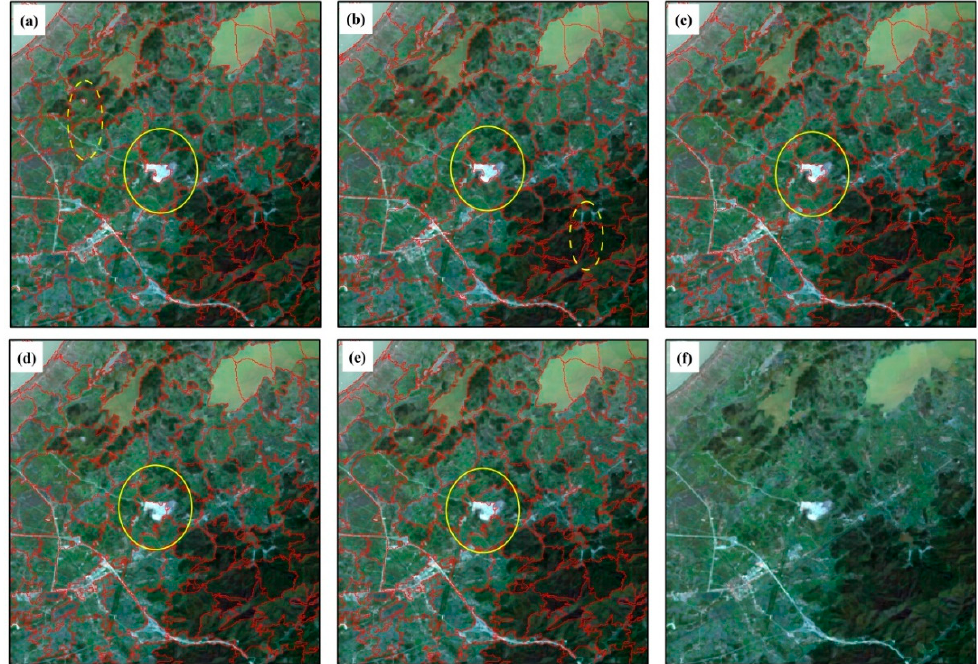
Figure 9. Image segmentation results for different spectral standard deviations in a typical area. The spectral standard deviations are ( a ) 0.15, ( b ) 0.20, ( c ) 0.25, ( d ) 0.30, and ( e ) 0.35. ( f ) The Landsat-8 OLI true color composite.